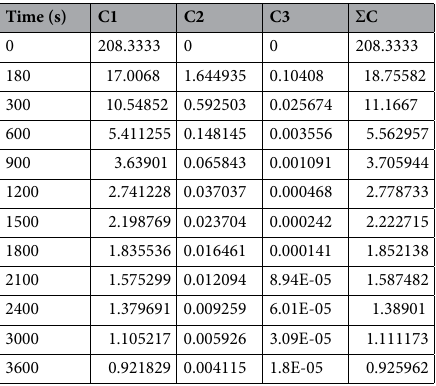
Table 4. Particle evolution with time for the AQEF/PNSC process at K b = 0.0635 Lg −1 min −1 , C 0 = 119.26 gL −1 and τ = 1.90